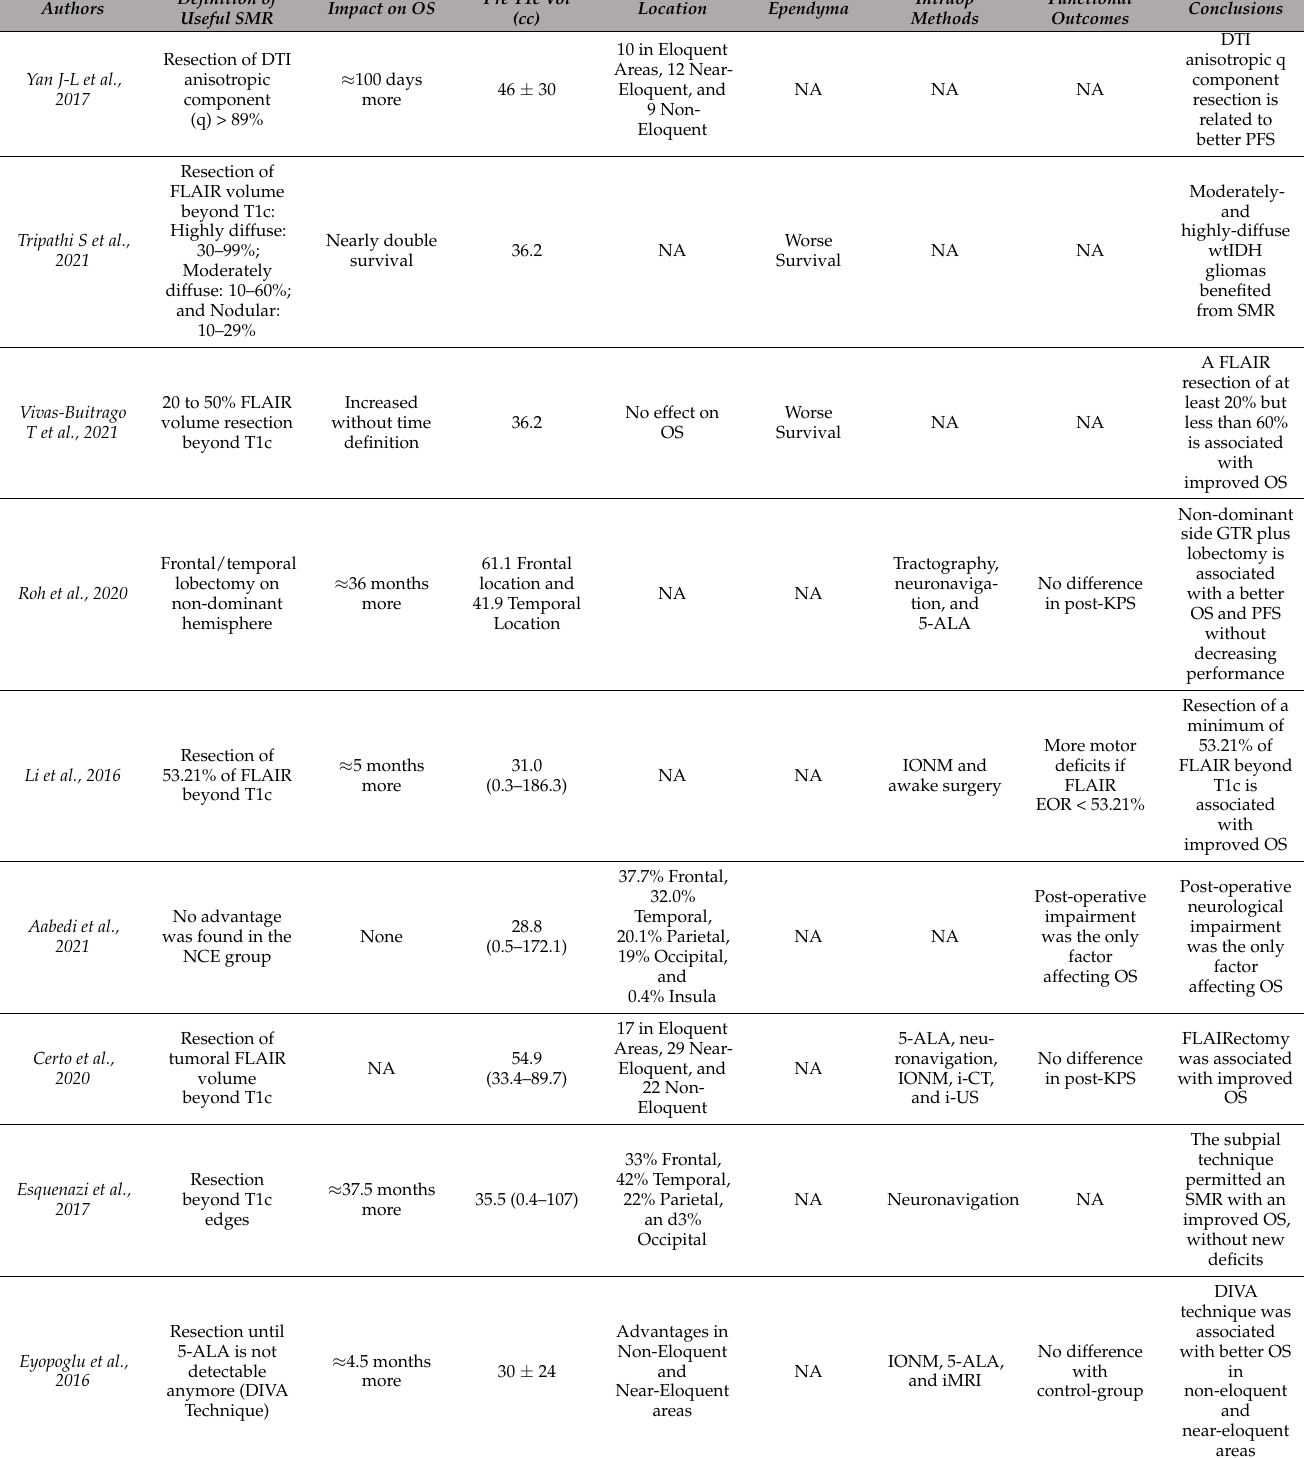
Table 1. Data of clinical studies . The table shows data collected from clinical studies. Pre T1c vol (cc): pre-operative T1w plus gadolinium tumor volume; Ependyma: involvement of ventricular of periventricular white matter; Intraop Methods: intraoperative methods; NA: not available; iMRI: intraoperative MRI; IONM: intraoperative neurophysiological monitoring; GTR: gross total